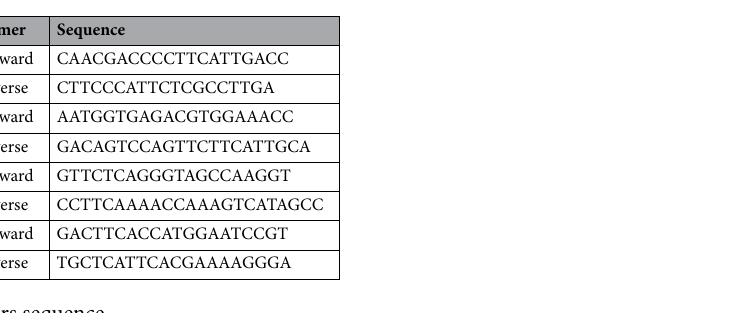
Table 3. qPCR primers